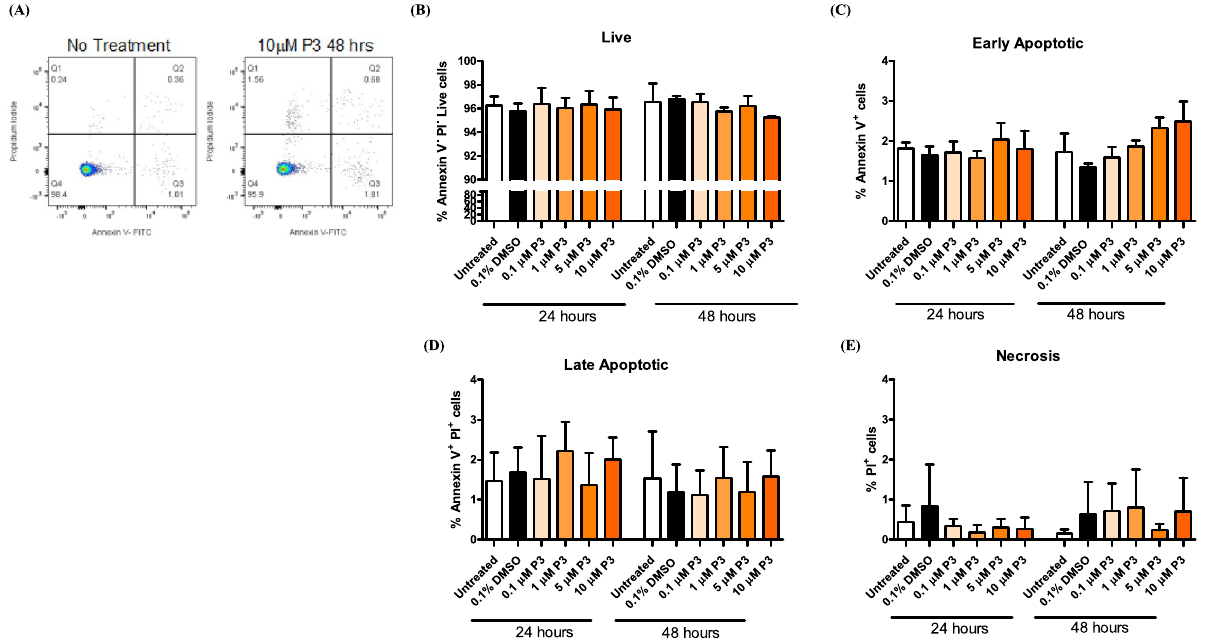
Figure 8. Pyrazinib (P3) does not alter T cell viability. The effect of Pyrazinib (P3) on Jurkat cell viability was assessed by flow cytometry. ( A ) Representive flow plot of utreated and Pyrazinib (P3) treated jurkat cells. The percentage of ( B ) live ( C ) early apoptotic ( D ) late apoptotic and ( E ) necrotic jurkat cells following 24 or 48 h treatment with media only, 0.1% DMSO control of 0.1, 1, 5 or 10 µM of Pyrazinib (P3), (n = 3). Paired